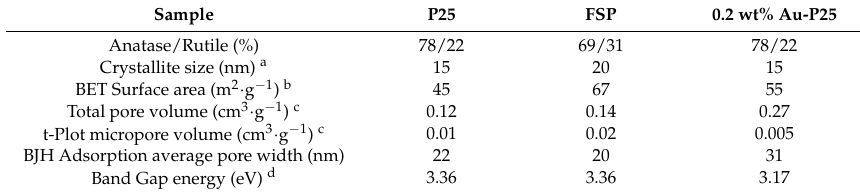
Figure 1. XRD patterns of P25 (1), 0.2 wt% Au-P25 (2) and FSP (3). A and R stand for anatase and rutile phases, respectively. Table 1. Some relevant properties of the samples, as derived by N 2 sorption isotherms at − 196 °C, XRD patterns and Band gap calculation from DR UV-Vis data elaborated according to Tauc plots.